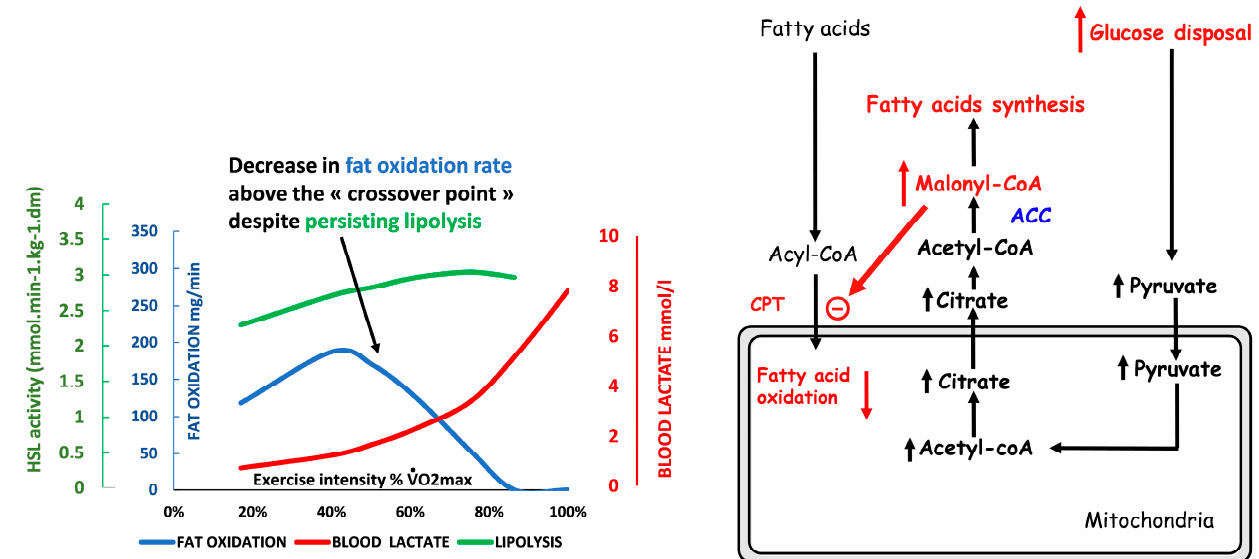
Figure 3. Schematic representation of the events explaining the “bell-shaped curve” of lipid oxidation when exercise intensity increases (see text). Lipolysis is not the limiting step and is still active far above the “crossover point”, but lipid oxidation is inhibited by the metabolites generated by the increase in the rate of CHO oxidation, which becomes the dominant fuel. At this intensity level, blood lactate increases because of the high rate of carbohydrate processing. Therefore, the LIPOXmax (intensity where lipid oxidation reaches its top) occurs below the “crossover point”, the rise in blood lactate, and the ventilatory threshold. The drawing of lipid oxidation is obtained from our database including 5258 calorimetries, and the point of maximal lipid oxidation occurred at 47 ± 1% of VO 2 max. At the level of LIPOXmax, individuals oxidized 209.5 ± 1.37 mg/min of lipids. This level is widely variable among individuals. Lactate data are from [59] and intramuscular lipolysis from [60]. HSL: Hormone-sensitive lipase activity.